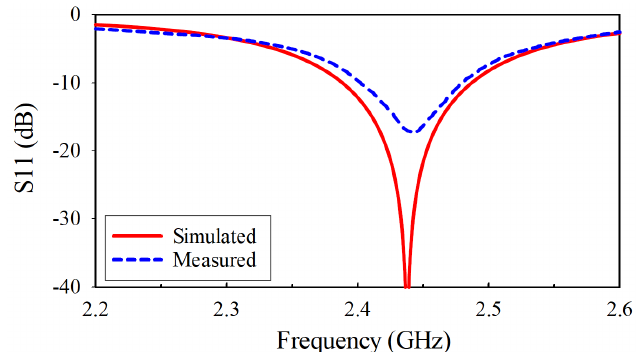
Figure 9. S 11 curve of BLE aperture-fed antenna (2.44 GHz center frequency).